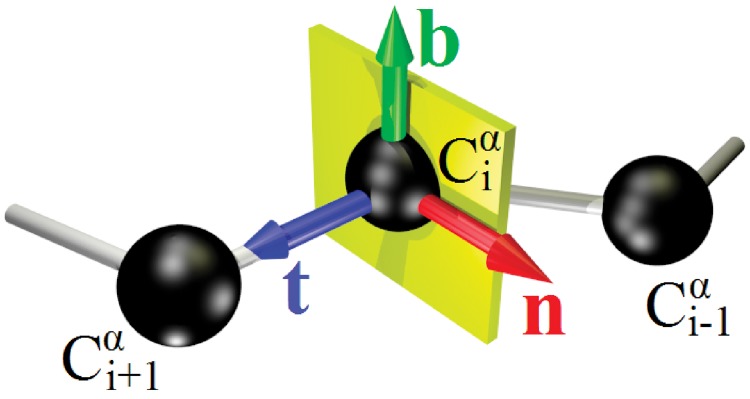
Discrete Frenet frame vectors (1), (2) and (3).